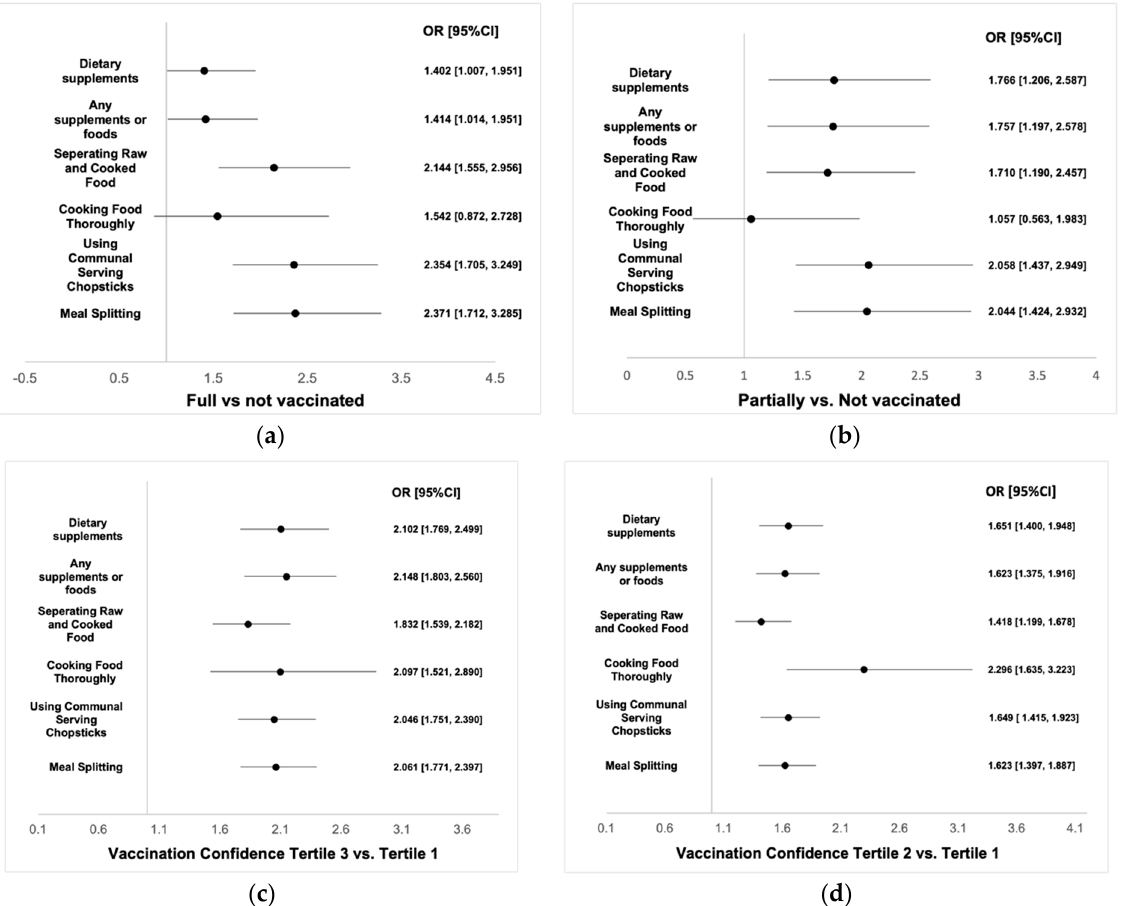
Figure 3. Supplement use and other dietary behaviors by vaccination status and confidence tertiles. ( a – d ): odds ratios for four comparisons: fully vs. not vaccinated, partially vs. not vaccinated, Tertile 3 vs. Tertile 1 (vaccination confidence) and Tertile 2 vs. Tertile 1 (vaccination confidence), respectively.